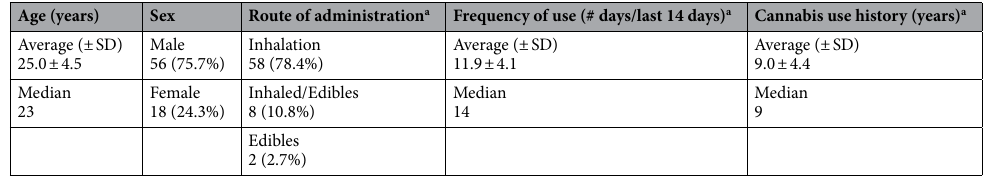
Average (± SD) 25.0 ± 4.5